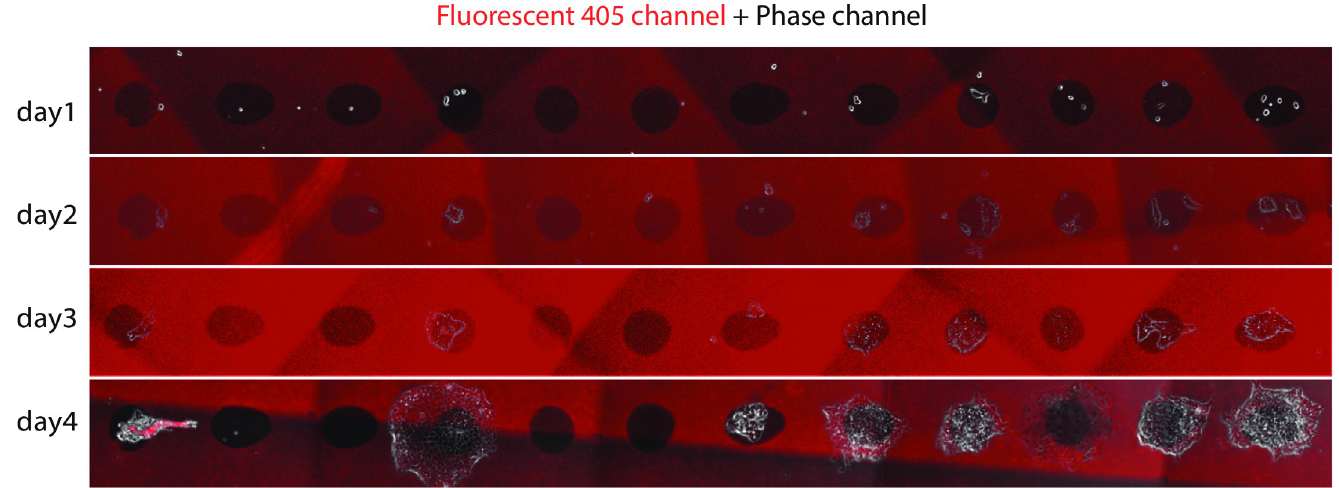
Fig 3. ESCs grew 4 days in the patterned surface. Cells preferred growing in the confined high-adhesive (not red) area, even if they were initially located on the edge. The pattern is boundary-free, so cells started expanding out at day 4. The red background is the fluorescent 405 channel, i.e., the low-adhesive zone. The uneven shading is due to the scanned image overlapping (similar as in Fig